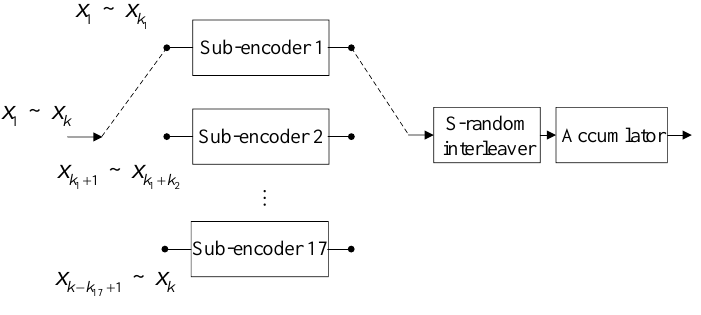
Figure 4. Demonstration of IrCC encoding.